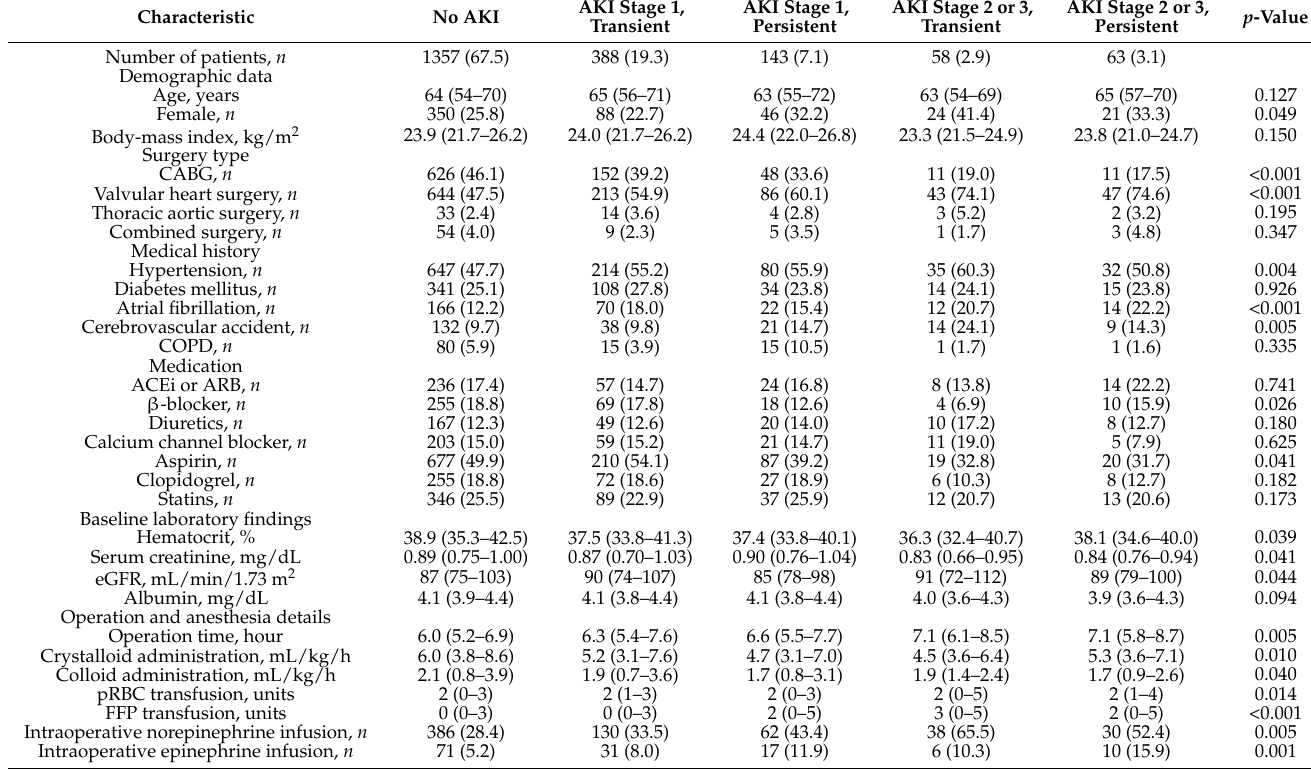
Table 1. Comparison of demographics and baseline clinical parameters across the stages of acute kidney